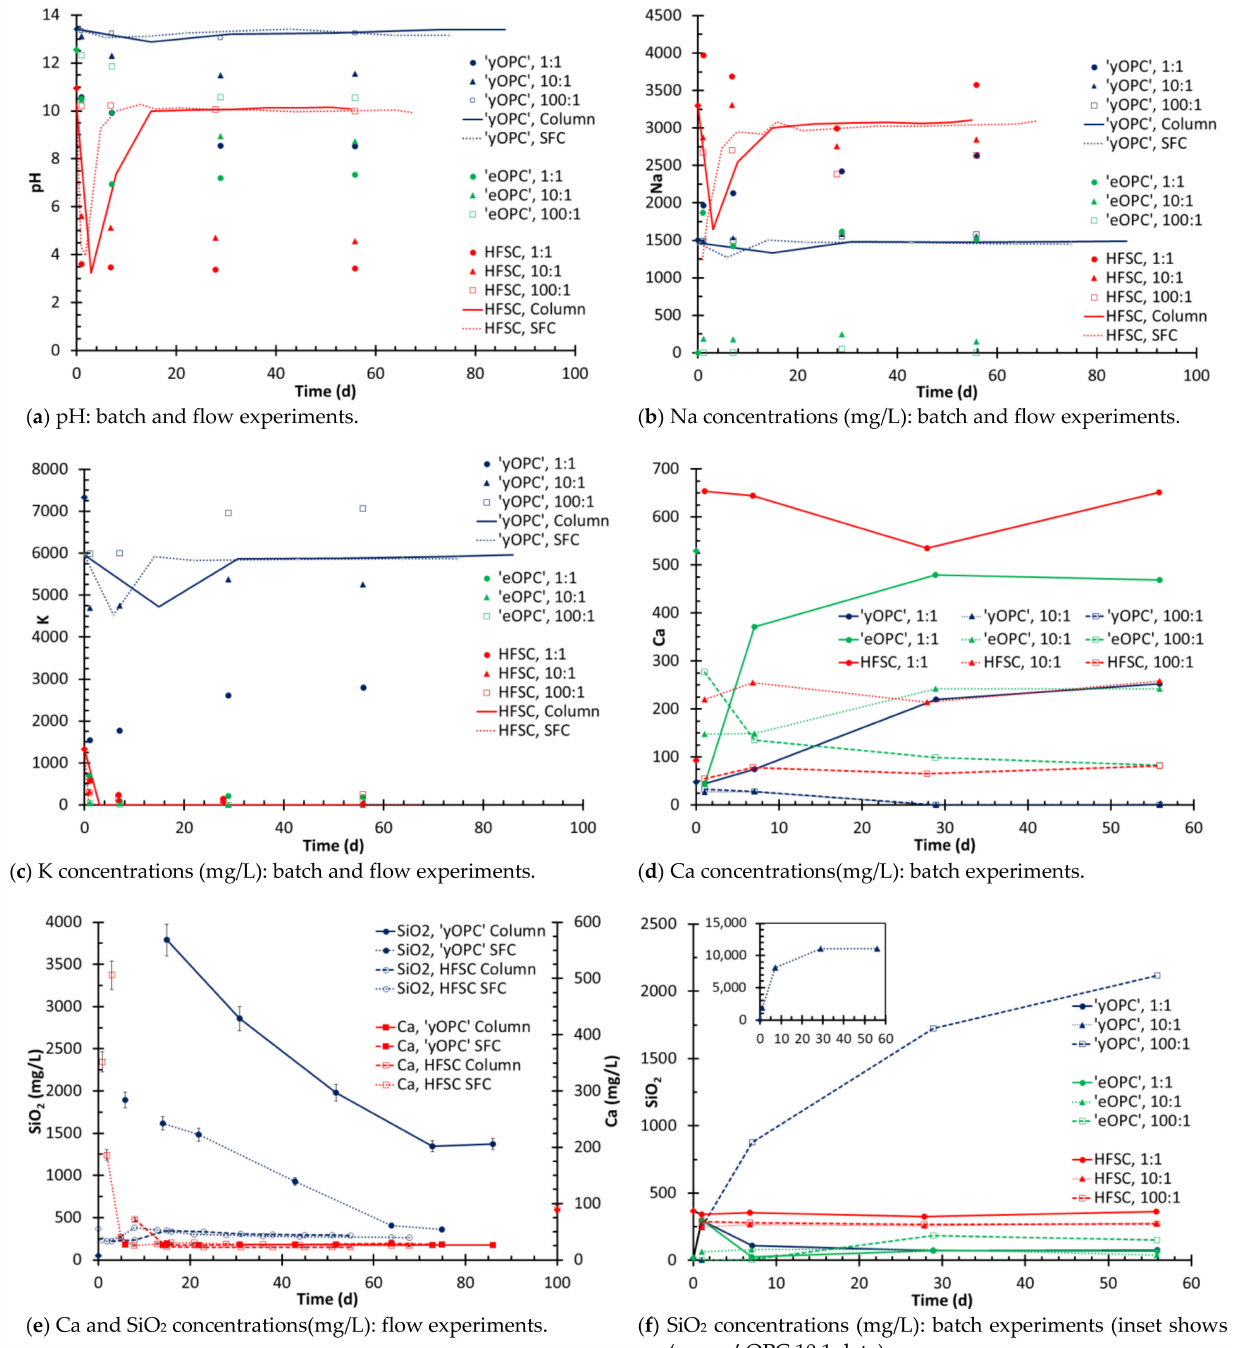
Figure 2. Changes in fluid chemistry with time. ( a ) pH batch and flow experiments; ( b ) [Na] batch and flow experiments; ( c ) [K] batch and flow experiments; ( d ) [Ca] batch experiments; ( e ) [Ca] and [SiO 2 ] flow experiments; ( f ) [SiO 2 ] batch experiments (inset shows ‘young’ OPC 10:1 data). Diamonds on the vertical axis indicate initial leachate concentrations. In the graphs where both batch and flow data are shown together ( a – c ), the single points indicate data from batch experiments, and the lines the flow experiments. Legend text: yOPC—‘young’ OPC leachate; eOPC—‘evolved’ OPC leachate; HFSC— HFSC424 leachate. For batch experiments, the F:S is